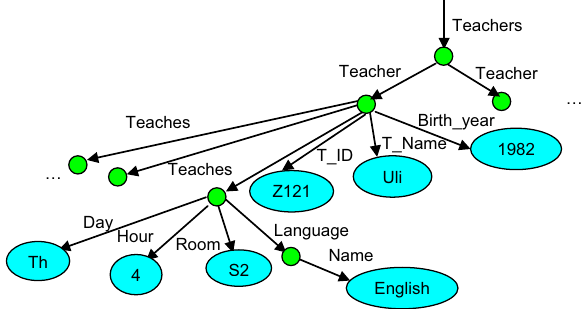
populations). The second component of a town couple can be ε . Due to the tree representation, for example the town Berlin will represented twice in such XML tree. Similarly, if more teachers learn German, representation of German language would be repeated in the XML document. This observation reflects the fact that XML data is textual, even for numeric data. Moreover, no conceptual view is supposed for this